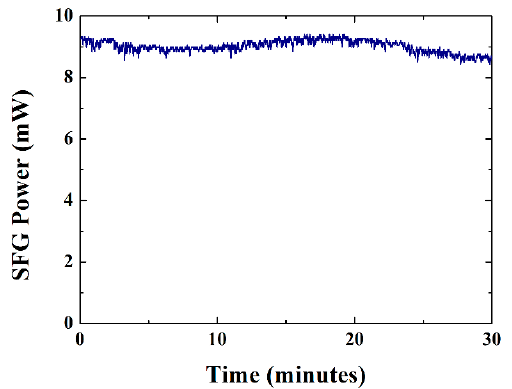
Figure 5. Fluctuation of the generated orange light measured at maximum power output for triple-wavelength operation at room temperature ( Δ T = 0 °C).